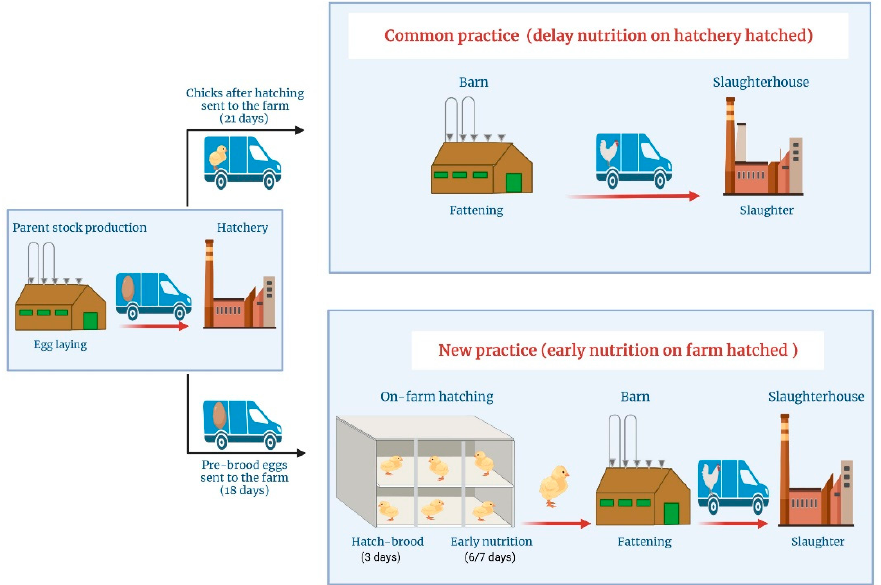
Figure 1. Concept of common hatching practice (delay nutrition on-hatchery hatched) versus the new strategy of early nutrition on-farm hatched. (Figure was created with BioRender.com, in August, 20 th 2021).